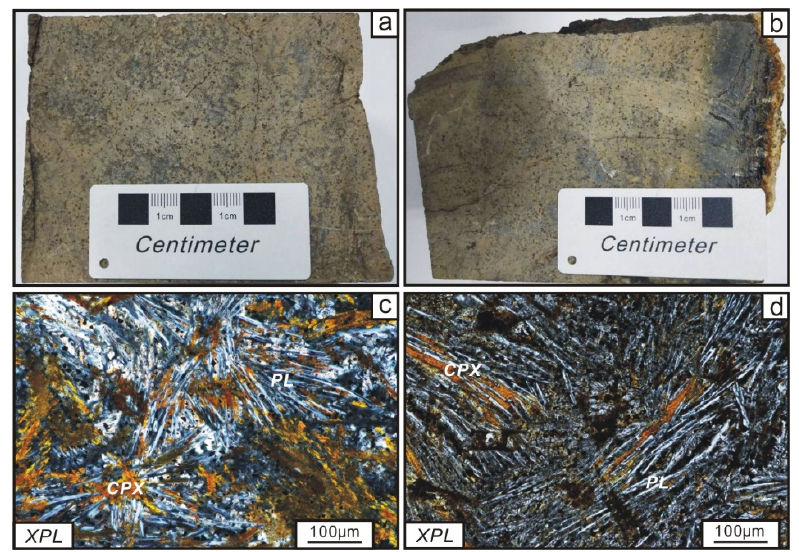
Figure 2. Macroscopic photos illustrating a hand specimen of a mafic rock collected from CBF in WPB with ( a ) a pervasive isotropic, aphanitic (volcanic) fabric or ( b ) a vesicular structure, with a glassy outer margin. Photomicrographs of basalts with a ( c ) spherulitic texture or ( d ) trachytic texture. Abbreviations (in alphabetical order): CPX, clinopyroxene and PL, plagioclase.